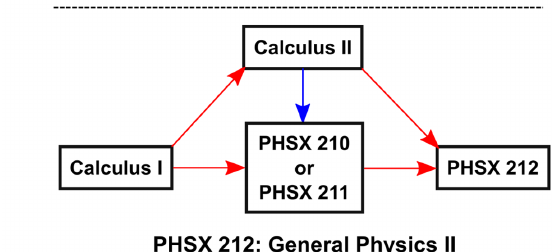
FIG. 7. The prerequisites and corequisites for CE 301 (Statics and Dynamics), ME 312 (Basic Engineering Thermodynamics), and PHSX 212 (General Physics II). All of these courses require Calculus II in addition to General Physics I.